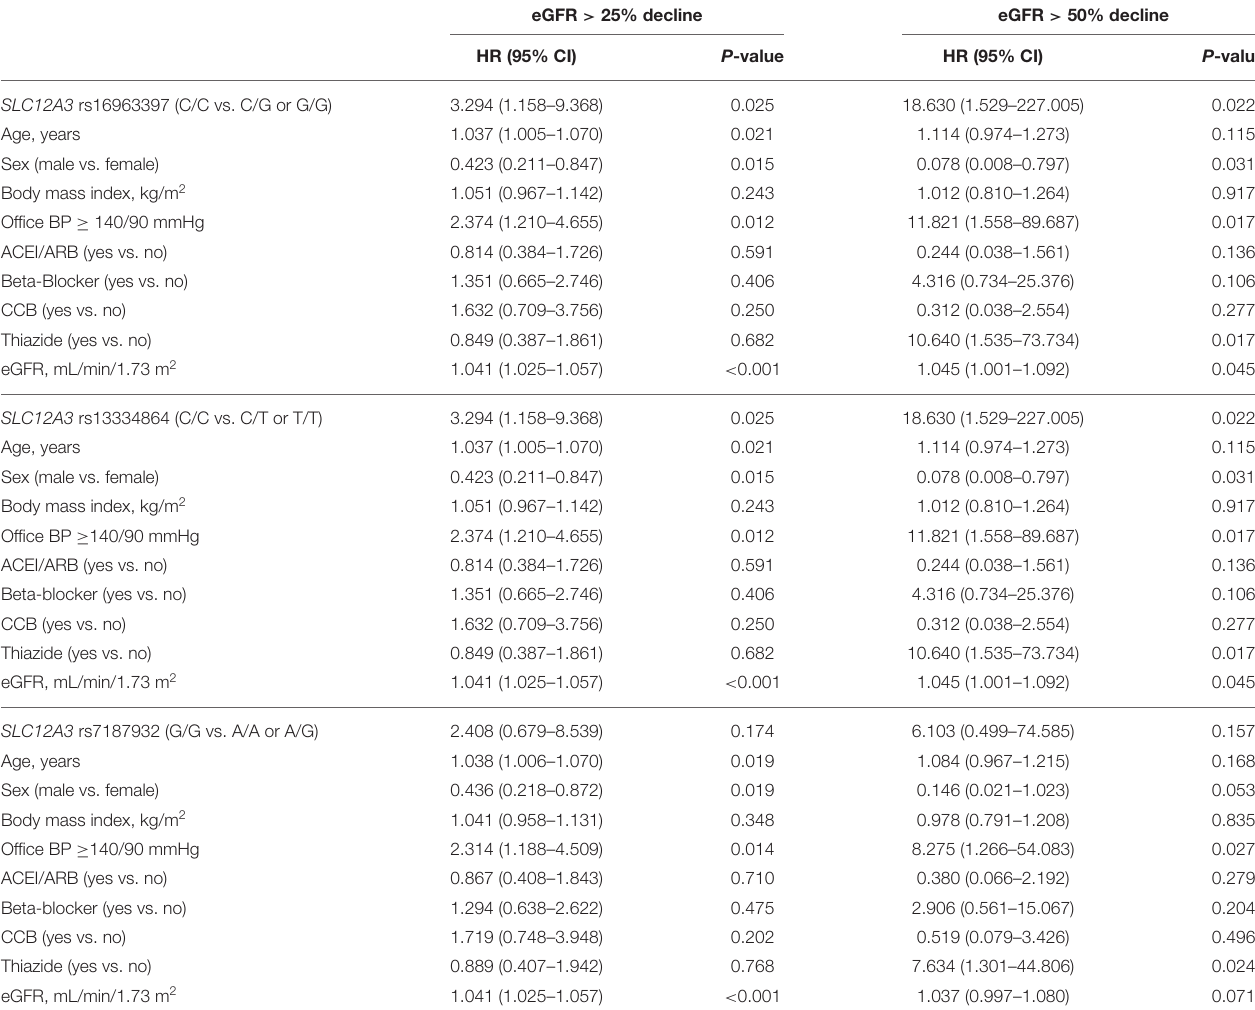
TABLE 4 | SLC12A3 gene polymorphisms and renal function decline (cohort